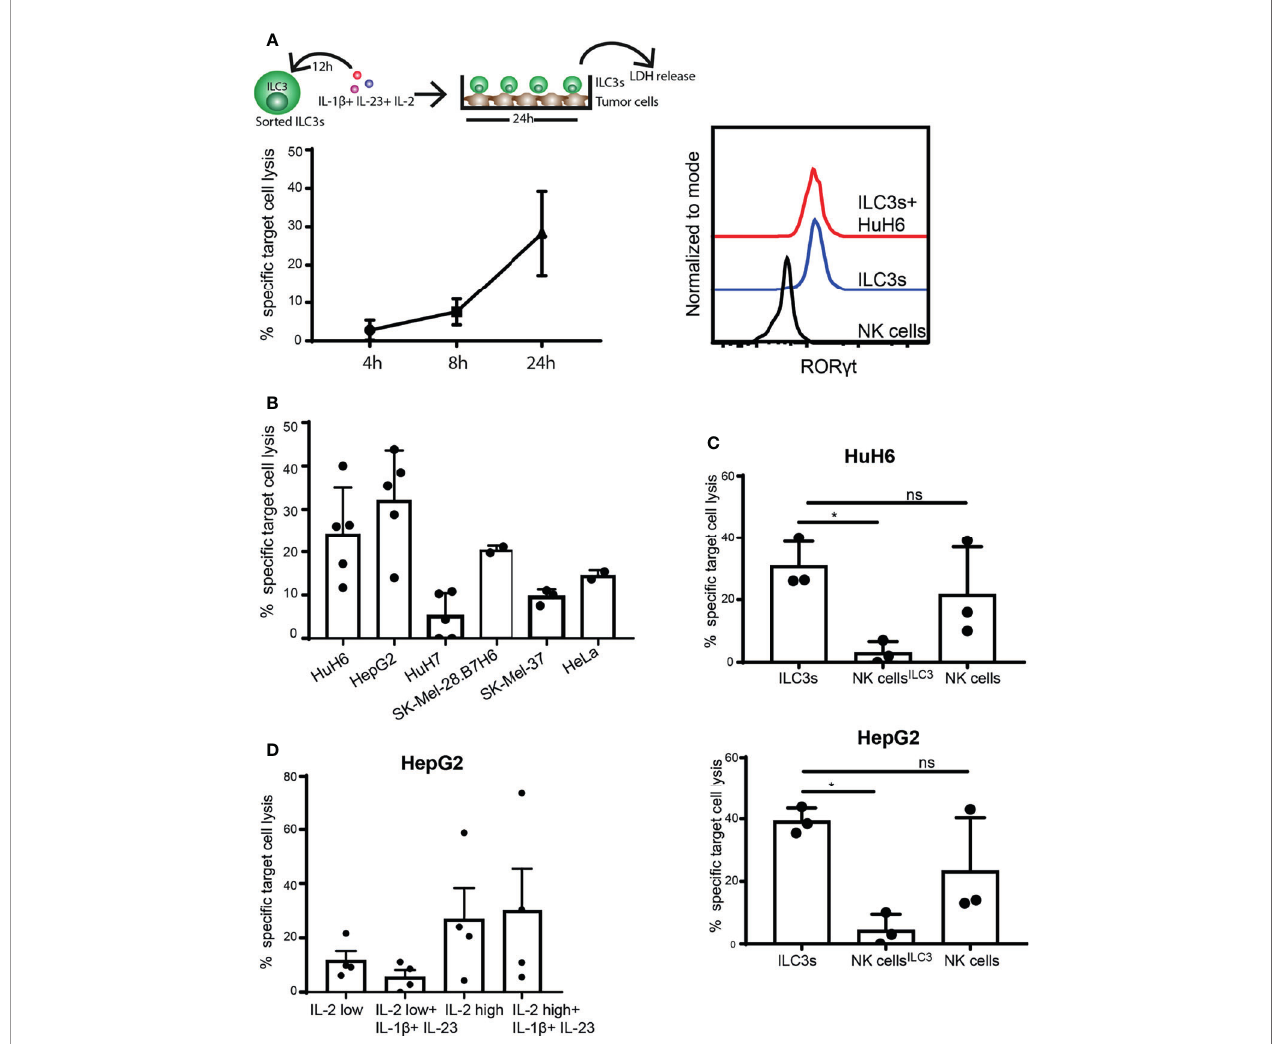
FIGURE 2 | ILC3s exert cytotoxicity against tumor cells. (A – C) Sorted blood ILC3s were stimulated overnight with 100 ng/ml IL-1 b , 100 ng/ml IL-23 and 10 U/ml IL-2. Afterwards, cells were washed and co-cultured with different tumor cell lines for 24h in the presence of 10 U/ml IL-2. (A) Speci fi c target cell lysis of the hepatoblastoma cell line HuH6 after 4h, 8h and 24h of co-culture with ILC3s (n=3 blood donors, E:T ratios 5-9:1, depending of ILC3 yield per donor) (left). Representative histograms of ROR g t expression by NK cells (control), ILC3s and ILC3s cultured with HuH6 cells (right). (B) Speci fi c target cell lysis after 24h co-culture of indicated tumor targets with ILC3s (n=2-5 blood donors, E:T ratios 10-15:1). (C) NK cells were maintained in same conditions as ILC3s (NK cells ILC3 ) or with 400 U/ml IL-2 (NK cells) for 12h. Afterwards, cells were washed and co-cultured with HuH6 (up) or HepG2 cells (down) in the presence of 10 U/ml IL-2 for 24h. Speci fi c target cell lysis was determined (n=3 blood donors, E:T ratios 9-12:1). ns, not signi fi cant, *p <0.05, by one-way Anova. (D) Sorted ILC3s were maintained in low (10 U/ml) or high (400 U/ml) concentration of IL-2 with or without IL-1 b and IL-23 for 24h, prior to co-culture with HepG2 tumor targets (E:T ratios 5-12:1). Speci fi c target cell lysis was determined for n=4 blood